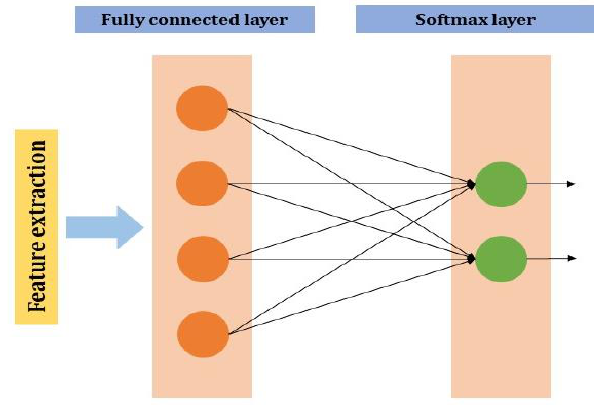
Figure 4. Fully connected layer in CNN.